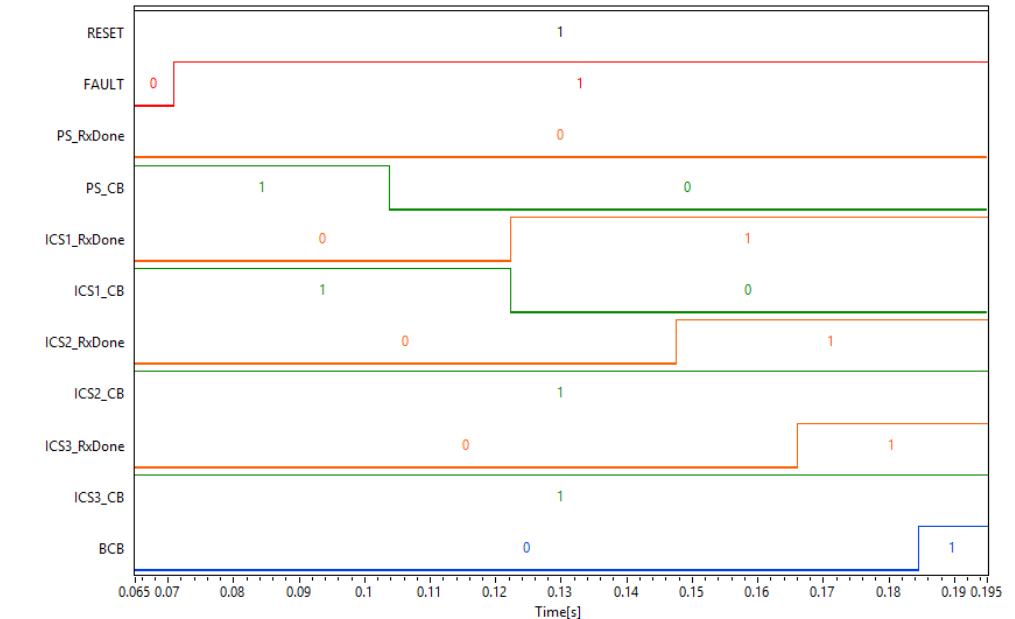
Figure 11. Digital signals acquired during the fault 50.S3 between SR and